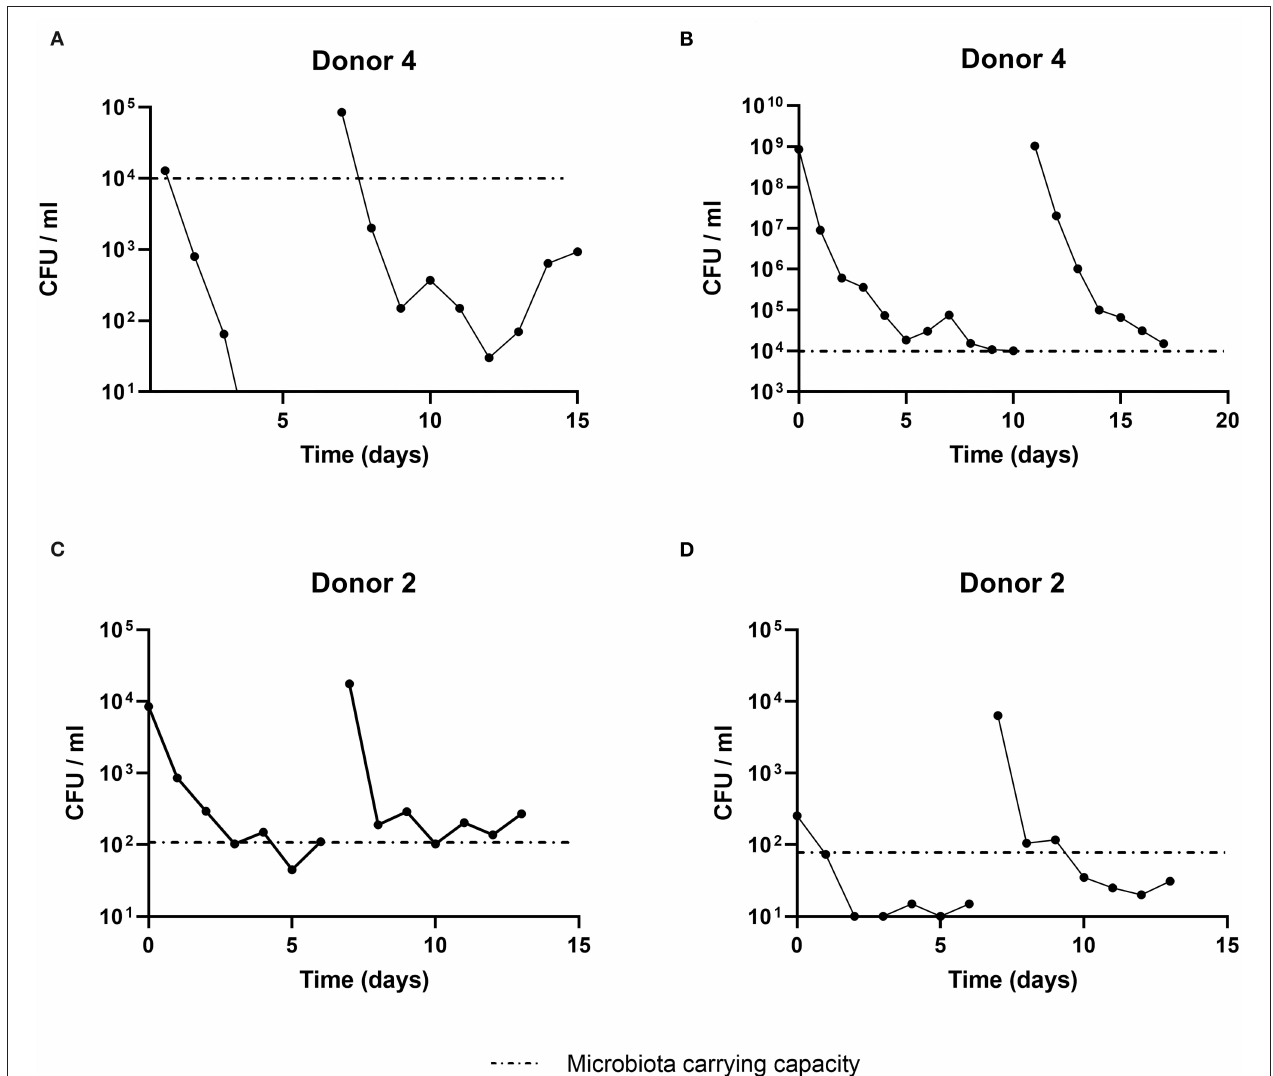
FIGURE 4 | Effect of a second L. plantarum introduction dose on final colonization level. L. plantarum was added a second time to TR7 (A) and TR2 (B) containing colonic microbiota of donor 4 at days 7 and 11, respectively. Similarly, L. plantarum was added to TR1.4 (C) and TR2.4 (D) containing microbiota of donor 2 at days 0 and day 7. The y-axis represents L. plantarum viable cell counts per ml reactor effluent. The dashed line represents the present observed carrying capacity for L. plantarum in the corresponding colonic microbiota which is equal to the L. plantarum colonization level observed in parallel-operated